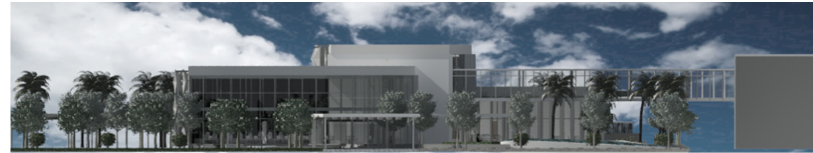
Figure 13. East elevation.